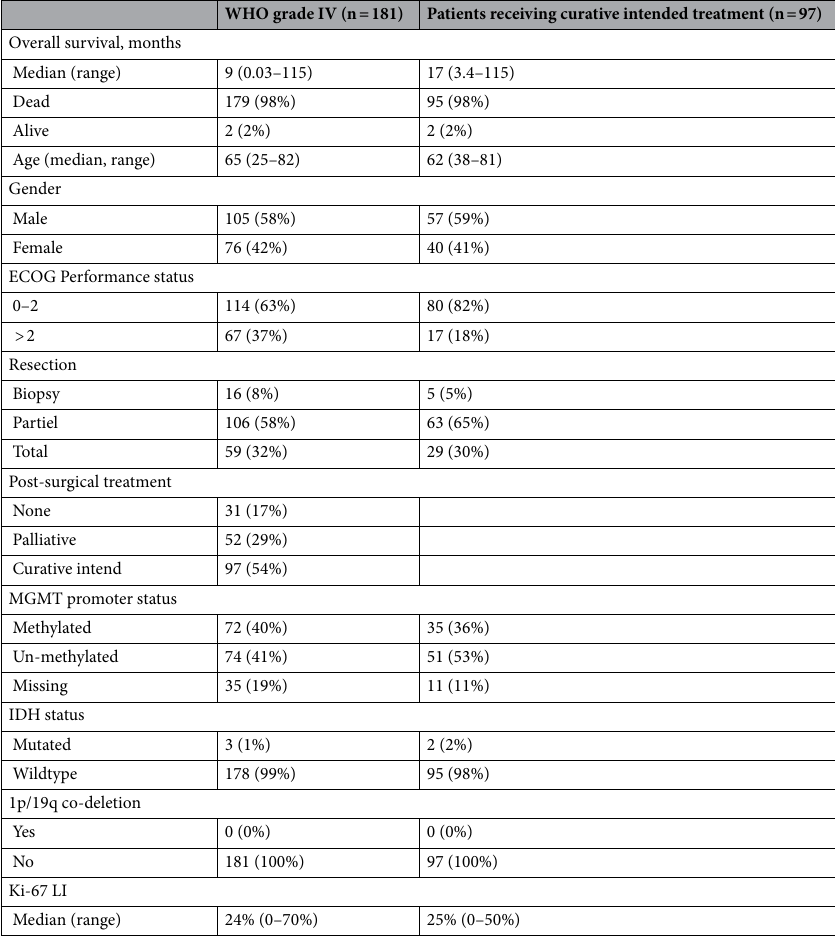
Table 1. Patient characteristics. Curative intended treatment consist of radiotherapy 59.4 Gy/33 fractions with concommitant and adjuvant Temozolomide and palliative treatment is radiotherapy 34 Gy/10 fractions or chemotherapy. ECOG = Eastern Cooperative Oncology